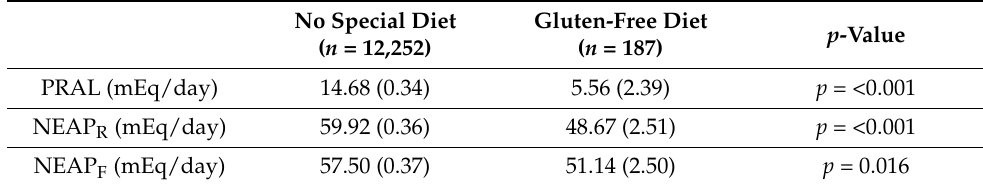
Table 4. Sample characteristics: dietary acid load